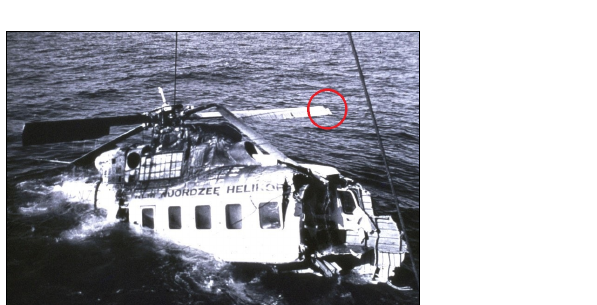
Figure 5 – Recovery of the helicopter Sikorsky S-61N PH-NZD from the North Sea Рис . 5 – Извлечение вертолета Sikorsky S-61N PH-NZD из Северного моря Slika 5 – Spasavanje helikoptera Sikorsky S-61N PH-NZD iz Severnog mora